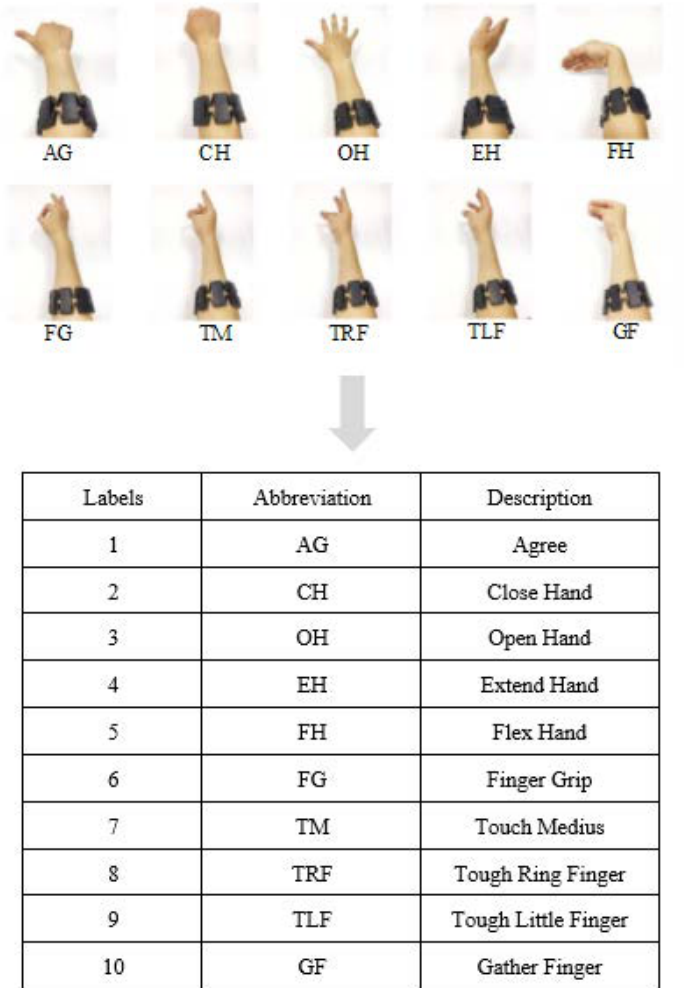
Figure 3. Movement categories and